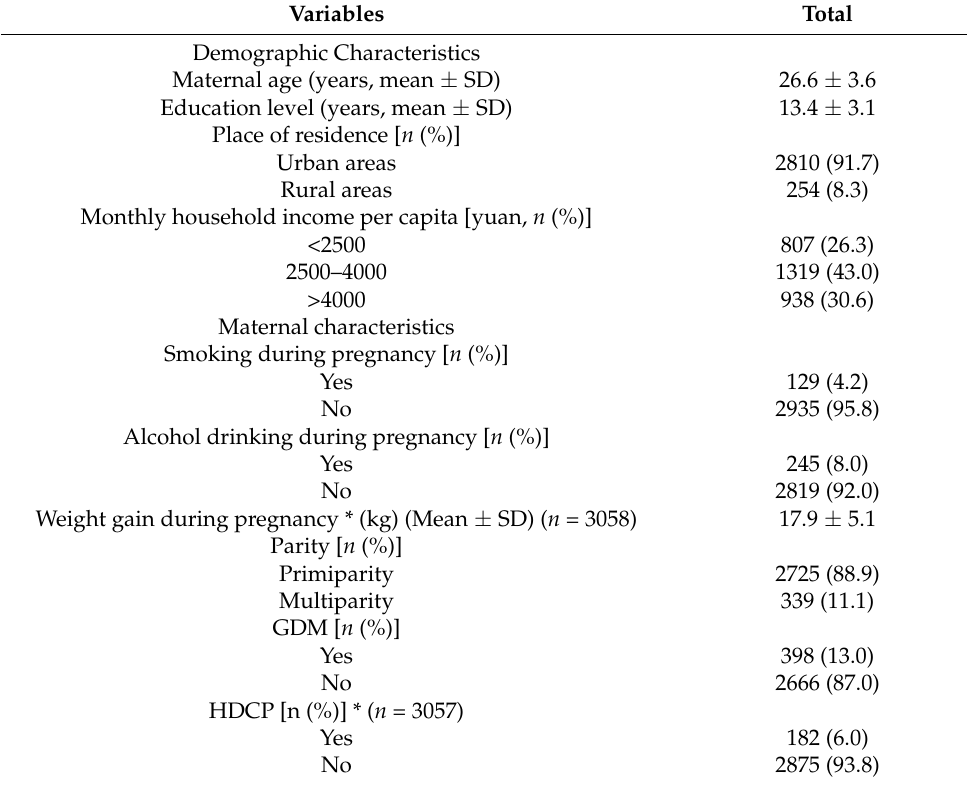
Table 1. Basic characteristics of participants ( n =